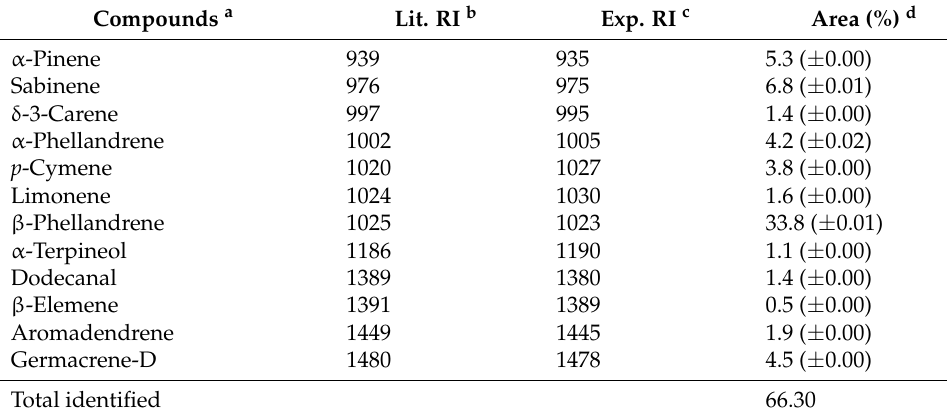
Table 1. Compositional analysis of Angelica purpurascens essential oil. Compounds